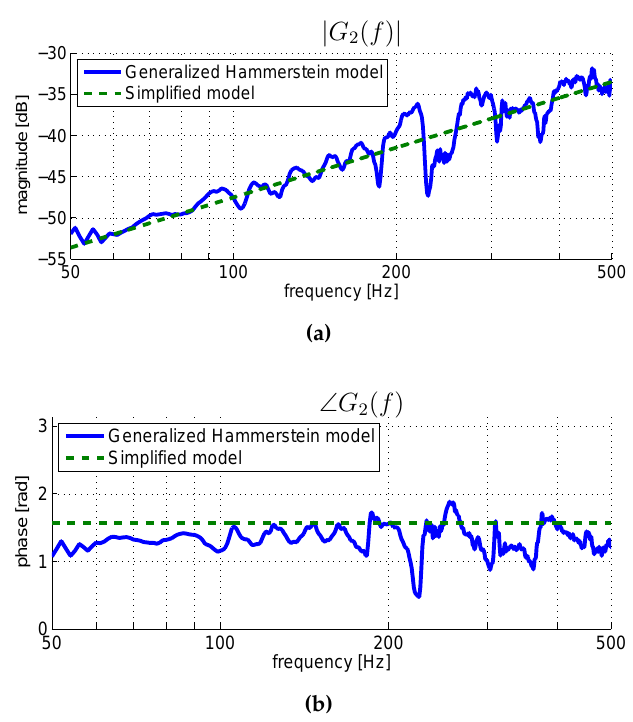
Figure 7. Modulus ( a ) and phase ( b ) of the first filter G 2 ( f ) of the identified Generalized Hammerstein model of the pickup under test (blue solid line) and the equivalent frequency response of the simplified Hammerstein model followed by a differentiator (green dashed line).